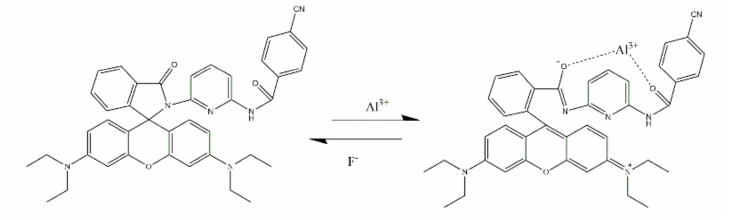
Figure 33. The proposed sensing mechanism of RBGP (Table 1, No. 43) to As 3+ [68]. RB-CR (Table 1, No. 44), conjugation between rhodamine B and phenylthiourea, was reported by Jiang T. et al. [69]. Spirolactam ring of RB-CR would open when triggered by Cr 3+ (Figure 34). The UV-Vis absorption and fluorescence signal of RB-CR displayed pronounced enhancement.